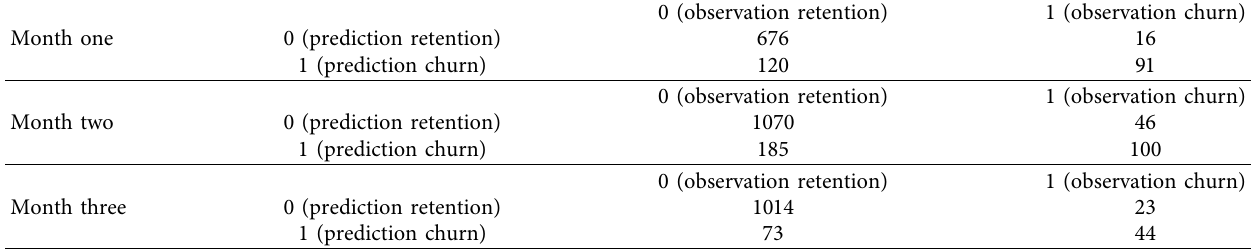
Table 4: True confusion matrix for the evaluation of customer churn